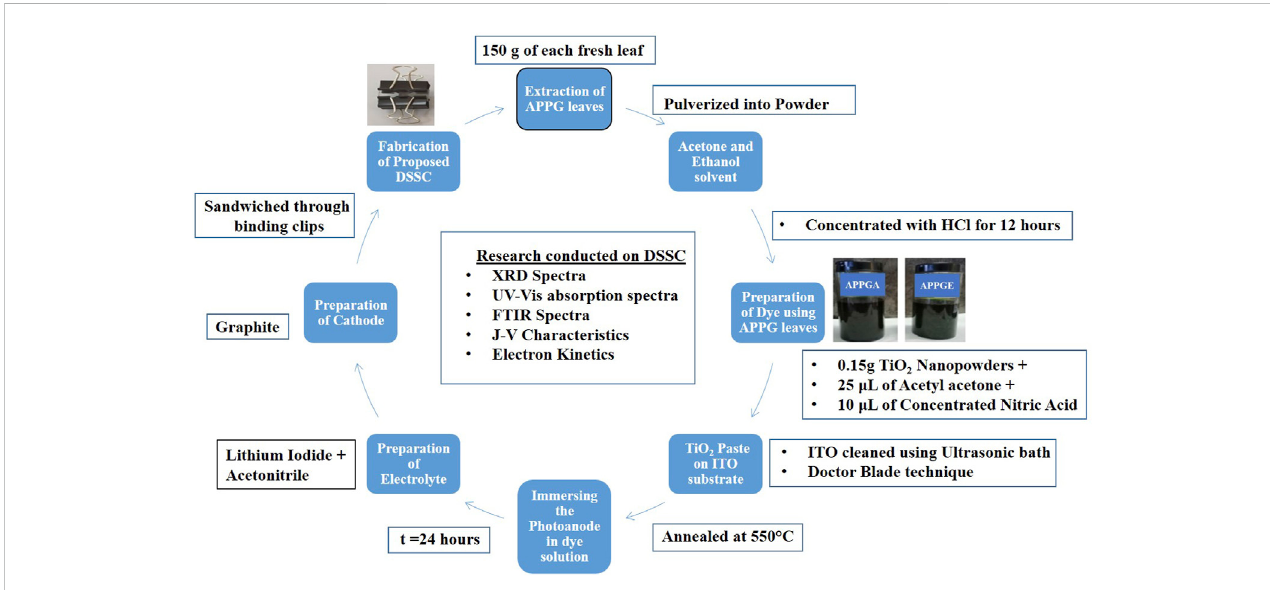
Schematic representation of the research conducted.